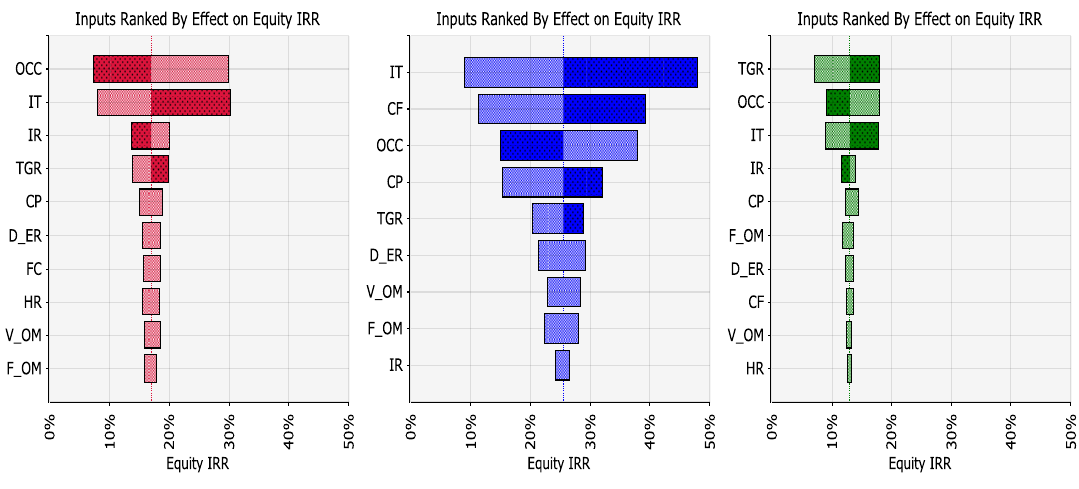
Figure 7. Equity IRR tornado diagrams of Coal, Wind, and Nuclear.